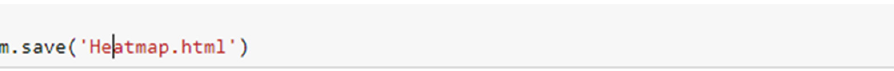
Figure 12. Saving the heatmap in .html format. The final heatmap can be viewed and zoomed in the browser (Figure 13).